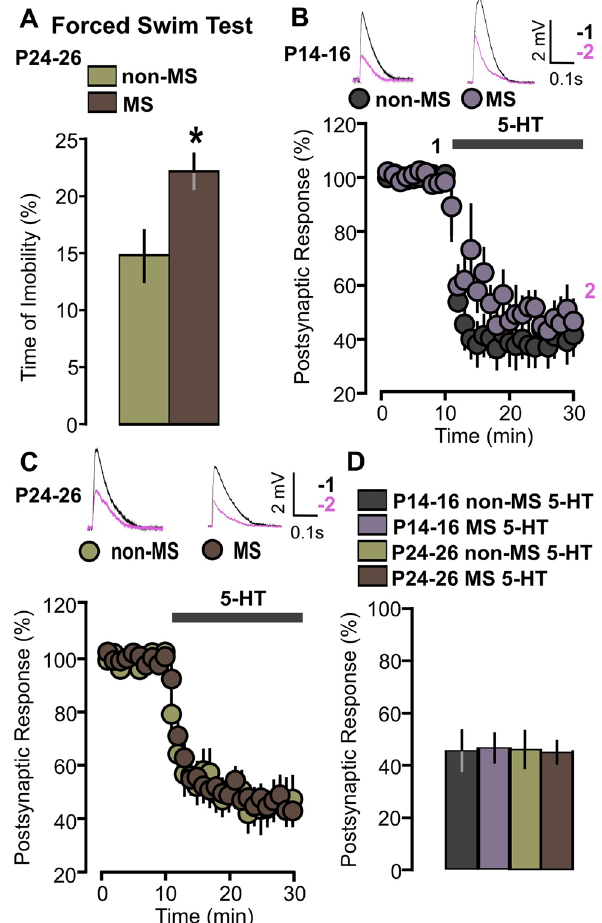
Figure 11. 5-HT reduces the amplitude of postsynaptic responses in MS animals. ( A ) The graph shows the time of immobility measured in the Forced Swim Test performed on P24-26 animals. Two groups of animals are compared: MS and non-MS. Bars represent the average of normalized (%) time of immobility with SEM. ( B ) The graph shows the EPSPs recorded in P14-16 animals before and during 5-HT bath application. The EPSPs were normalized to the mean of responses recorded during the baseline. Two different conditions are compared: non-MS (dark grey inserts) and MS (light violet) animals. The black bar represents the period of application of 5-HT (50 µM) in the bath. Traces show the results of a representative experiment with the average of postsynaptic responses recorded before (1: 5 to 10 min, black line) and after (2: 25 to 30 min, magenta line) application of 5-HT. ( C ) Graph showing the effects of 5-HT on the averaged post synaptic responses recorded during the 25–30 min period in P14-16 MS animals. EPSPs were normalized to the mean of responses recorded during the baseline. ( D ) The graph shows the EPSPs recorded in P24-26 animals before and during 5-HT bath application. The EPSPs were normalized to the mean of responses recorded during the baseline. Two different conditions are compared: non-MS (brown inserts) and MS (dark brown inserts) animals. The black bar represents the period of application of 5-HT (50 µM) in the bath. Traces show the results of a representative experiment with the average of postsynaptic responses recorded before (1: 5 to 10 min, black line) and after (2: 25 to 30 min, magenta line) application of 5-HT. ( E ) Graph showing the effects of 5-HT on the averaged post synaptic responses for the 25–30 min period in P24-26 MS animals. EPSPs were normalized to the mean of responses recorded during the